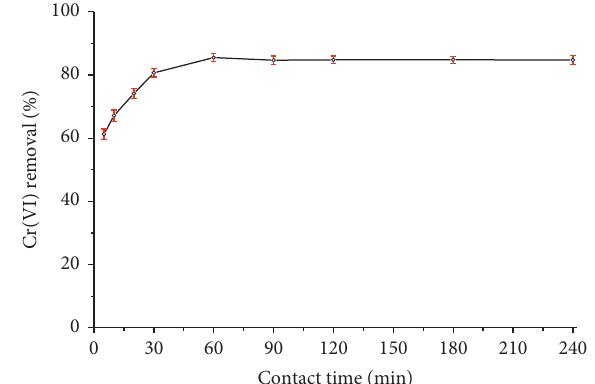
Figure 6: Effect of contact time on removal of Cr(VI) using organobentonite. Conditions: C i � 50mg/L, V � 50mL, T � 20 ° C, pH � 3.0, stirring speed � 200rpm, and HDTMA-Bent � 0.2g.